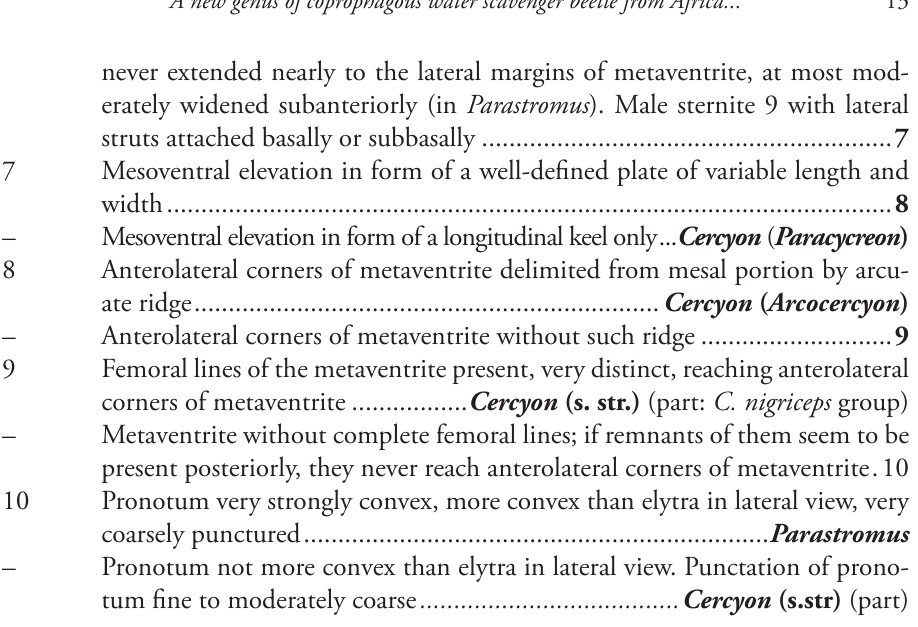
Figures on Flickr. https://www.flickr.com/photos/142655814@N07/albums/721576- 90290 894065 Material examined. Voucher specimens: ’Fort de Kock (Sumatra) 920 M., 1925, leg. E. Jacobson // Knisch det. 1925 punctigerum // A. d’Orchymont det. Cercyon punc- tigerus Knisch’ (5: RBINS); ’Sumatra, D.E. Museum // Knisch det. 1925 punctigerum ’ (1: RBINS); ’Insel Sumbawa // Knisch det. 1925 punctigerum // Latcho, Tonkin, de Cooman // A. d’Orchymont det. Cercyon punctigerum Knisch’ (1: RBINS); ’Pagsanjan, Luzon // A. d’Orchymont det. Cercyon punctigerum Knisch’ (1: RBINS). ’India mer., Tamil Nadu, Nilgiri Hills, 15km SE of Kotagiri, Kunchappanai, 76°56'E 11°22'N; 900 m a.s.l.; 17–28.ix.1993, D. Boukal & Z. Kejval legt. // Cercyon ( Acycreon ) puncti- ger Knisch det. M. Fikáček 2012’ (1: NMPC). Integument shining (Fig. 6a). Colouration reddish-brown with pale palpi. Eyes without thickened ridge at posterior margin (Fig. 7a.). Mentum subtrapezoid, with anterior